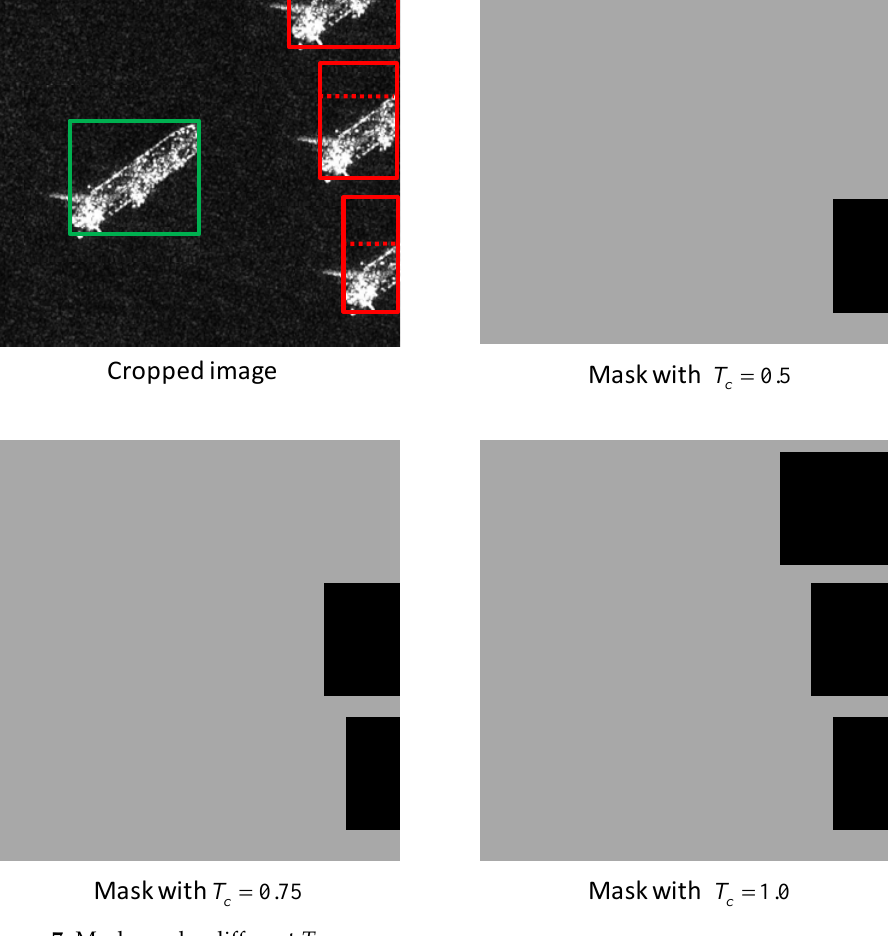
Figure 7. Masks under different